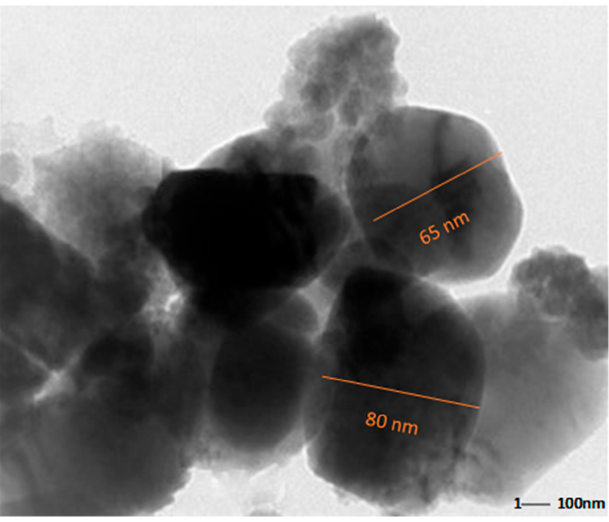
Figure 4. Transmission electron microscopic image of chitosan NPs, ranging from 65–80 nm .